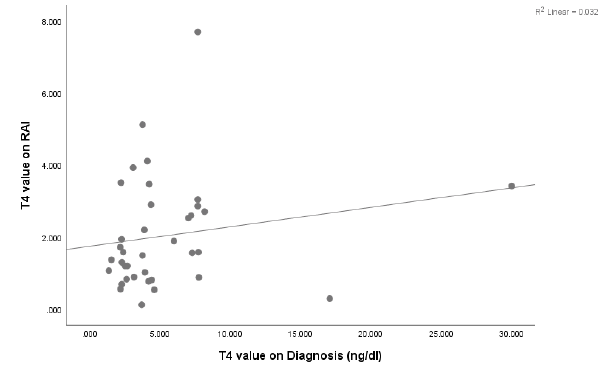
Figure 1: The Scatter plot showing the relationship between the FT4 value on diagnosis and the FT4 value before giving the Radioiodine therapy.